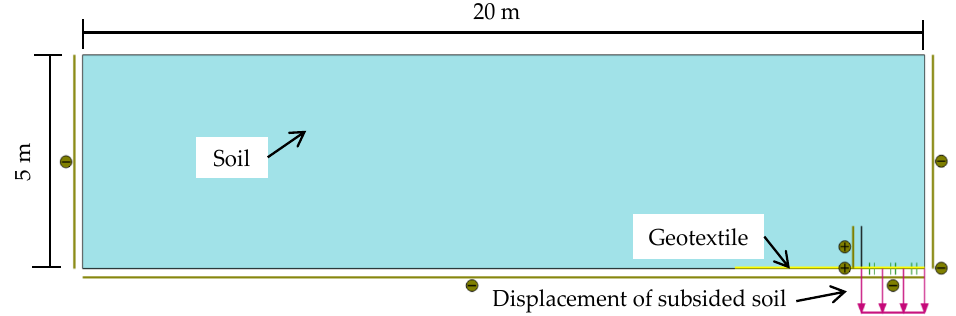
Figure 3. Numerical model.